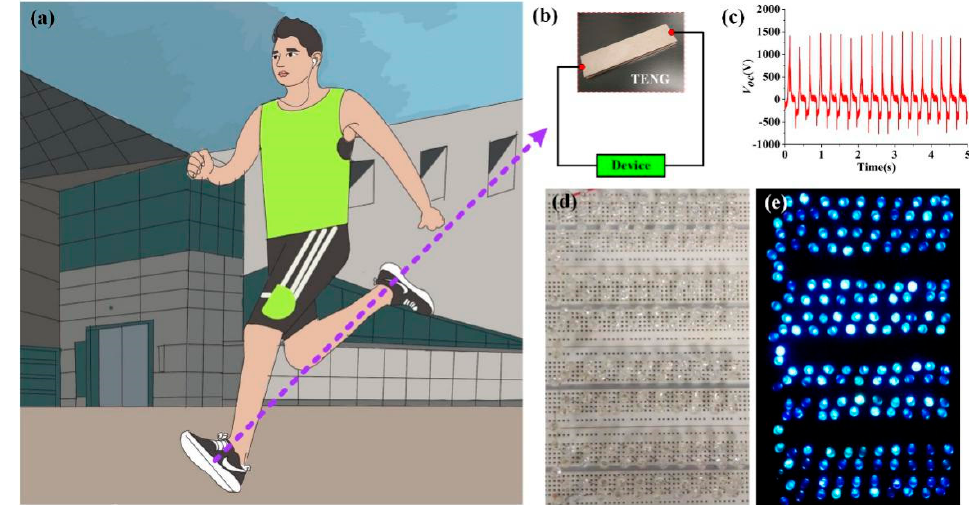
Figure 9. ( a ) The schematic of human walking. ( b ) Picture of the 5 cm × 20 cm fabricated TENG integrated into a shoe. ( c ) Approximate VOC of the TENG generated during human walking. ( d , e ) Photograph of the 172 high-power light-emitting diodes (LEDs) easily driven by the TENG during human walking.